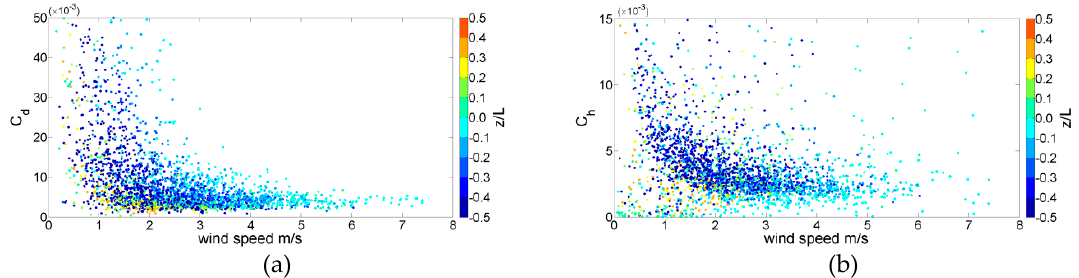
Figure 12. ( a ) Relationship between the C d and wind speed from 5 January to 31 December 2010. ( b ) Relationship between the C h and wind speed from 5 January to 31 December 2010.